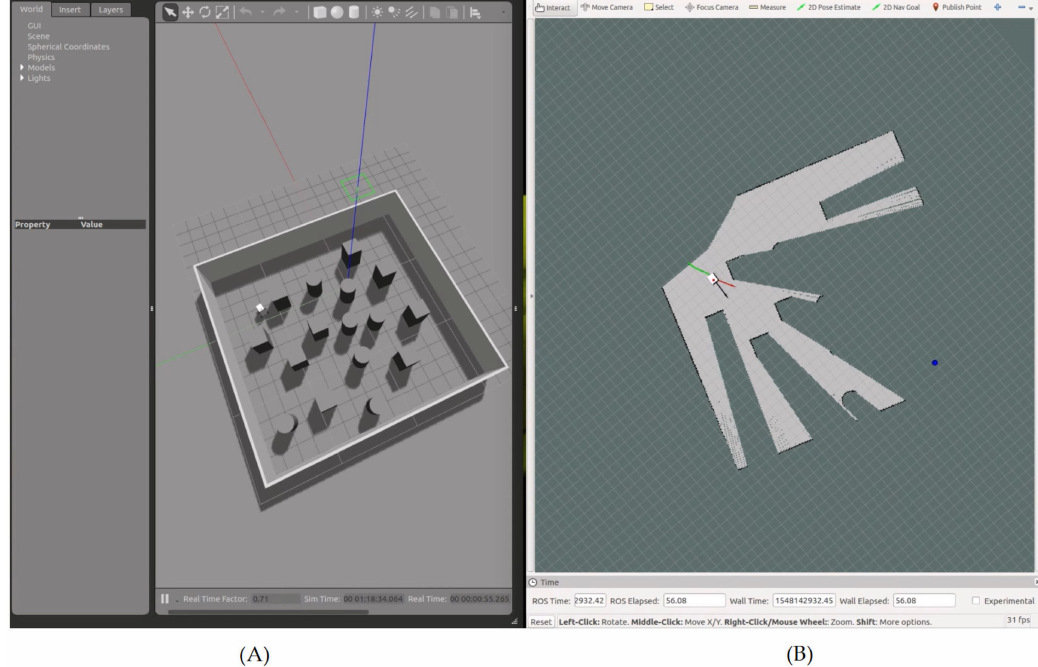
Figure 7. Simulation results showing the robot navigating toward waypoint n1, with the navigation area on Gazebo ( A ), and the simulated state of the robot on Rviz ( B ). On Gazebo ( A ), the red, green, and blue lines represent the 3D axis related to the navigation area. On Rviz ( B ), the robot is shown in white (3D model), and the waypoint is shown as a blue dot. The green line represents the saved path of the robot, the red arrow represents the heading β between the robot and the waypoint in the global frame, and the black arrow represents the actual heading θ of the robot (i.e., the result of using the heading to the waypoint α and the HWF for obstacle